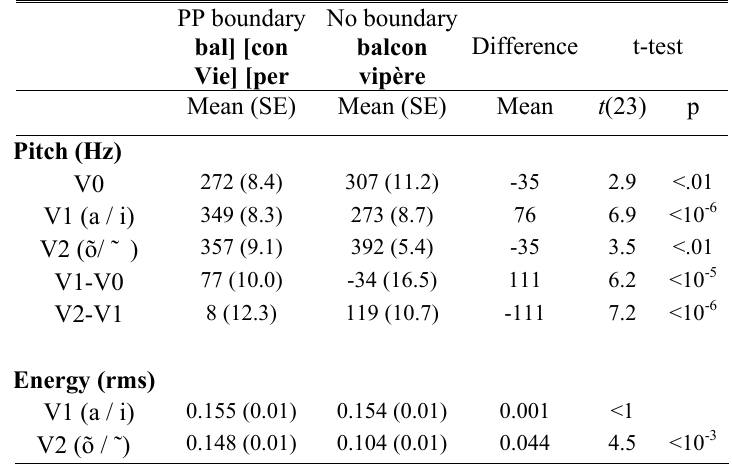
Table 2: Pitch and energy of the vowels constituting the critical sequences (‘balcon’ and ‘vipere’, V1 and V2 respectively), as well as one vowel before the critical sequence to compute pitch movements before phonological phrases (visible on the ellipses drawn on Fig.